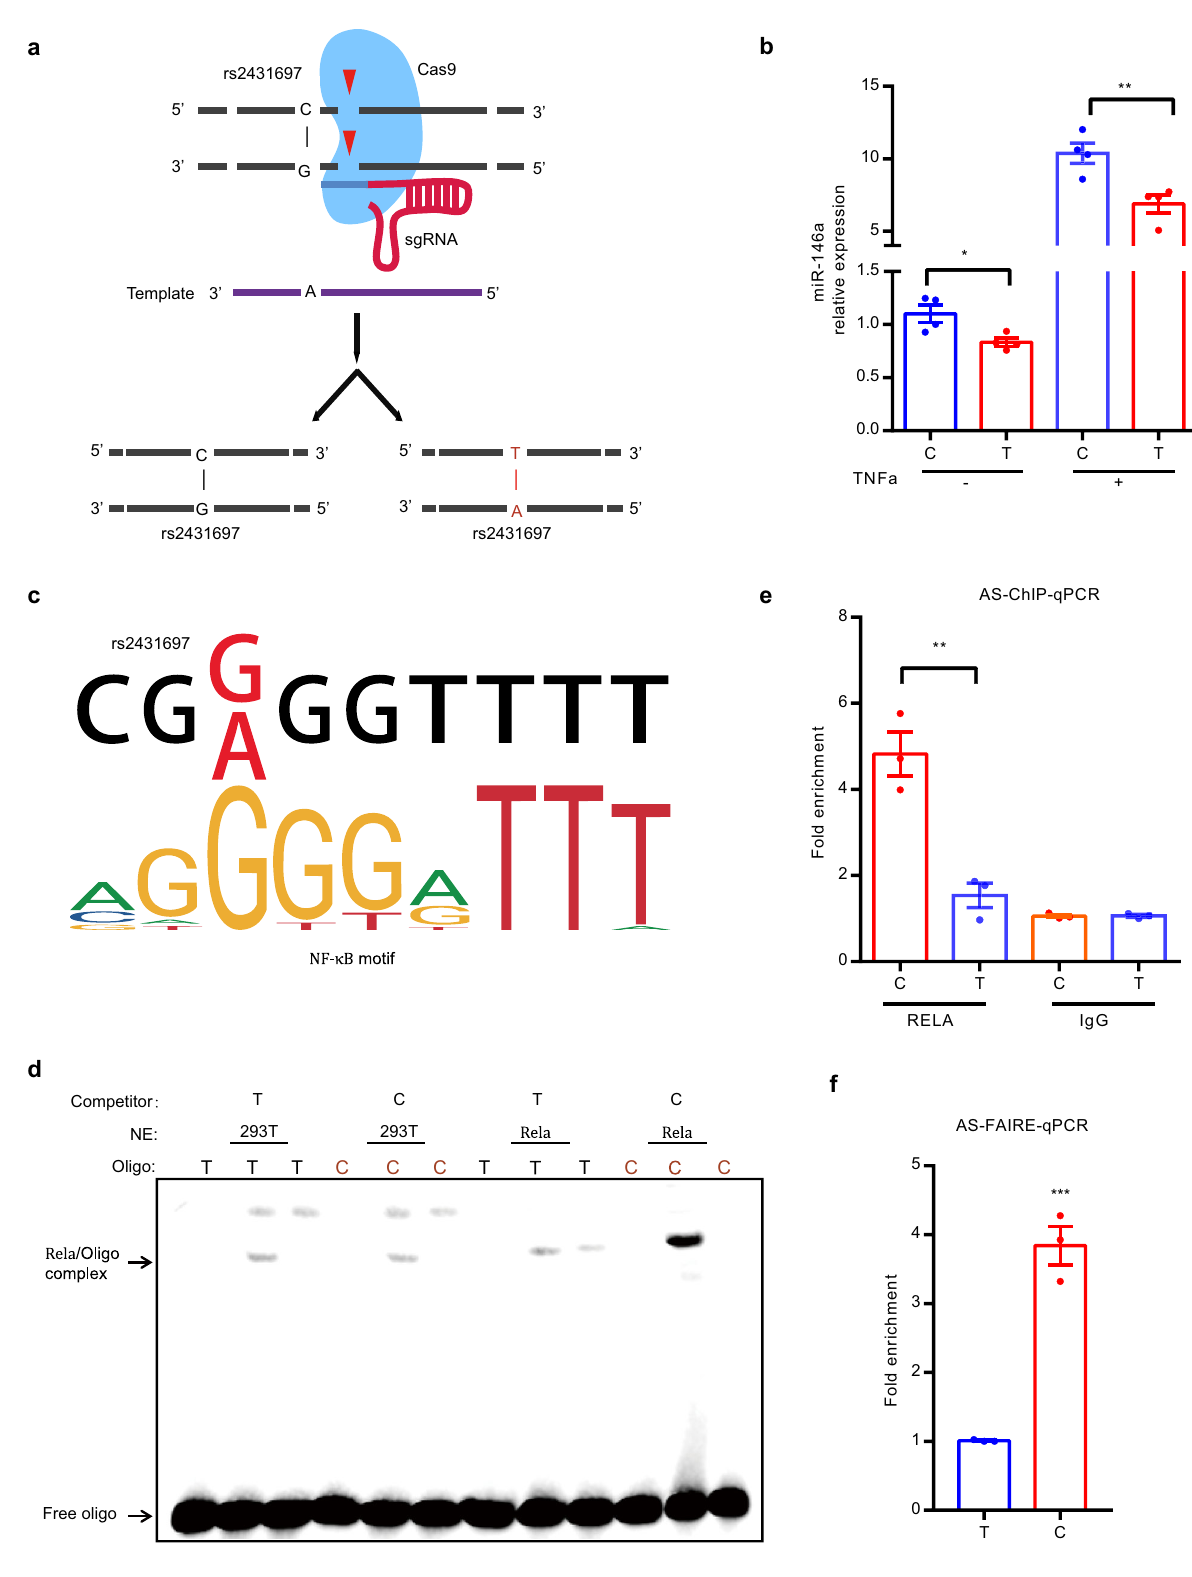
binding af fi nity, our results suggest a signi fi cant allele-speci fi c chro- matin state re fl ected by the H3K4me1 signal, H3K27ac signal, and chromatin accessibility, further detailing the mechanisms through which the rs2431697 T risk allele mediates its effects on SLE